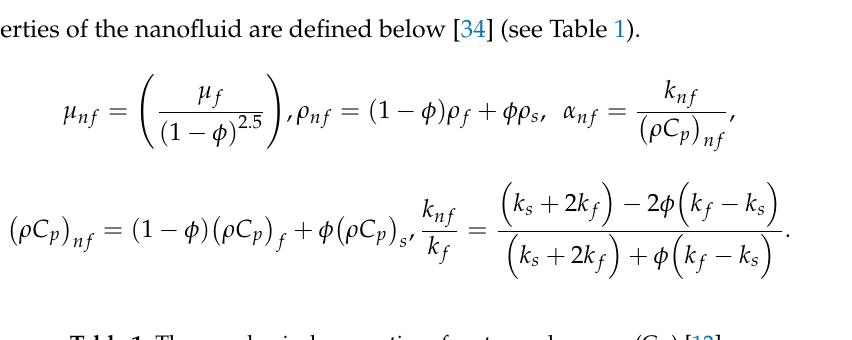
Table 1. Thermophysical properties of water and copper (Cu)